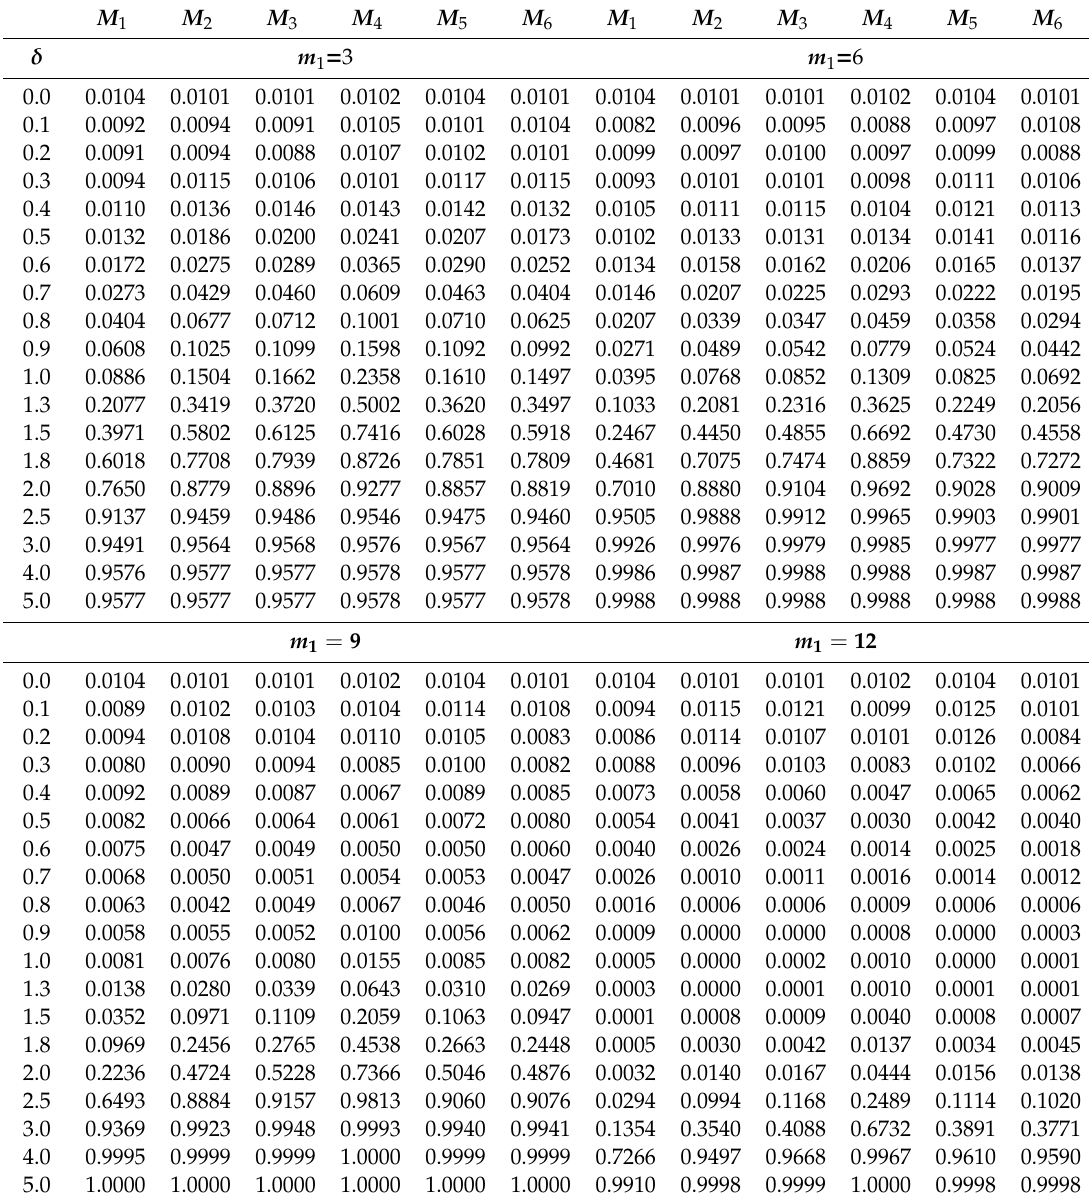
Table 3. Probability to signal values for the di ff erent median charts when m = 30, n = 10, ρ = 0.80 at various levels of δ and m 1 when α =